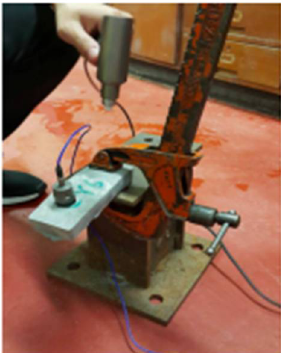
Figure 16. Damping test.